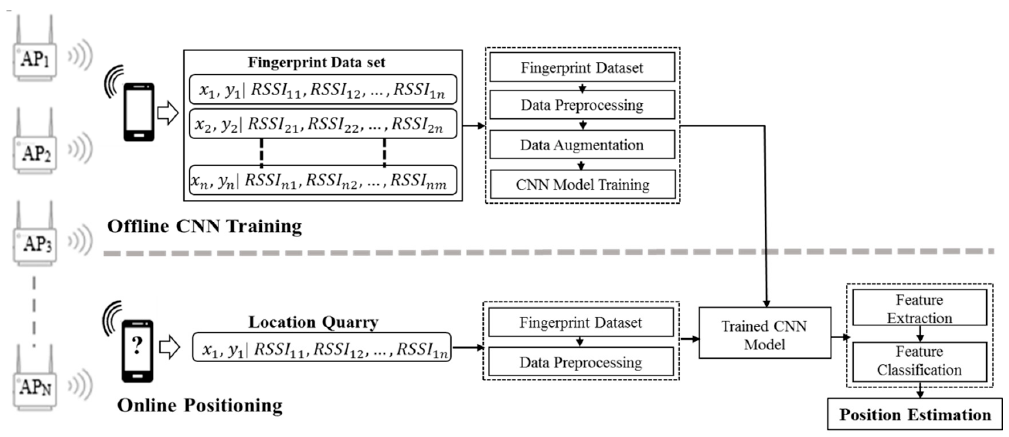
Figure 1. The fingerprint method (For offline deep neural network (DNN) training; a four-layer DNN-based localizer is trained to extract reliable features from massive noisy received signal strength indication (RSSI) samples from a pre-built fingerprint data set. For online positioning, the preprocessed RSSI readings are fed into the localizer to estimate the final position).